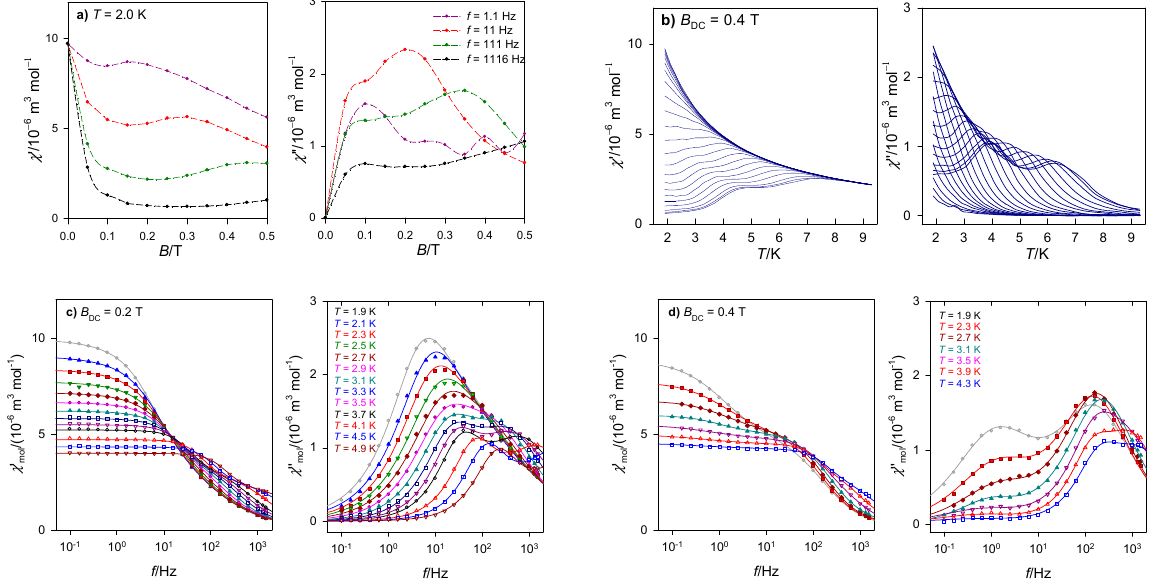
Figure 3. Ways of AC susceptibility data taking/analysis. AC susceptibility components: ( a ) field dependence, ( b ) temperature dependence, ( c , d ) frequency dependence. Data adapted from ref. [27]. 2017, Royal Society of Chemistry.